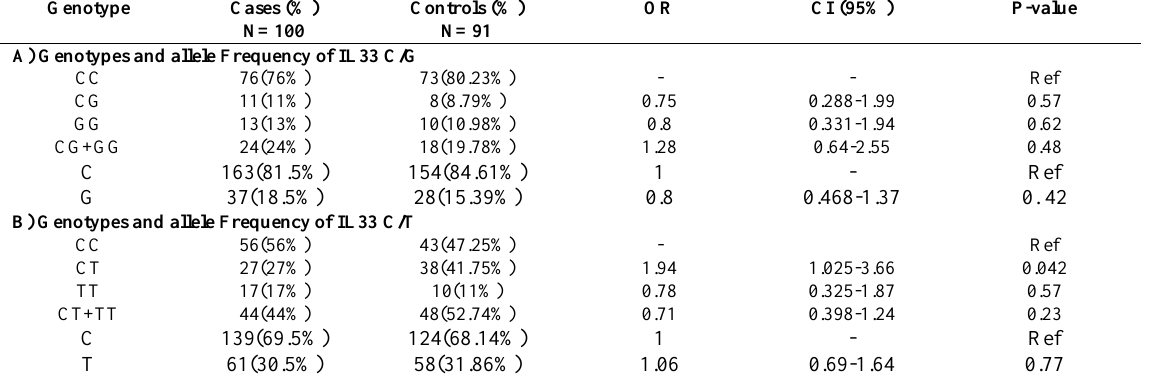
Table 3 . Genotype and allele frequency of IL-33 geneC/G and C/T polymorphisms in Tuberculosis patients and healthy